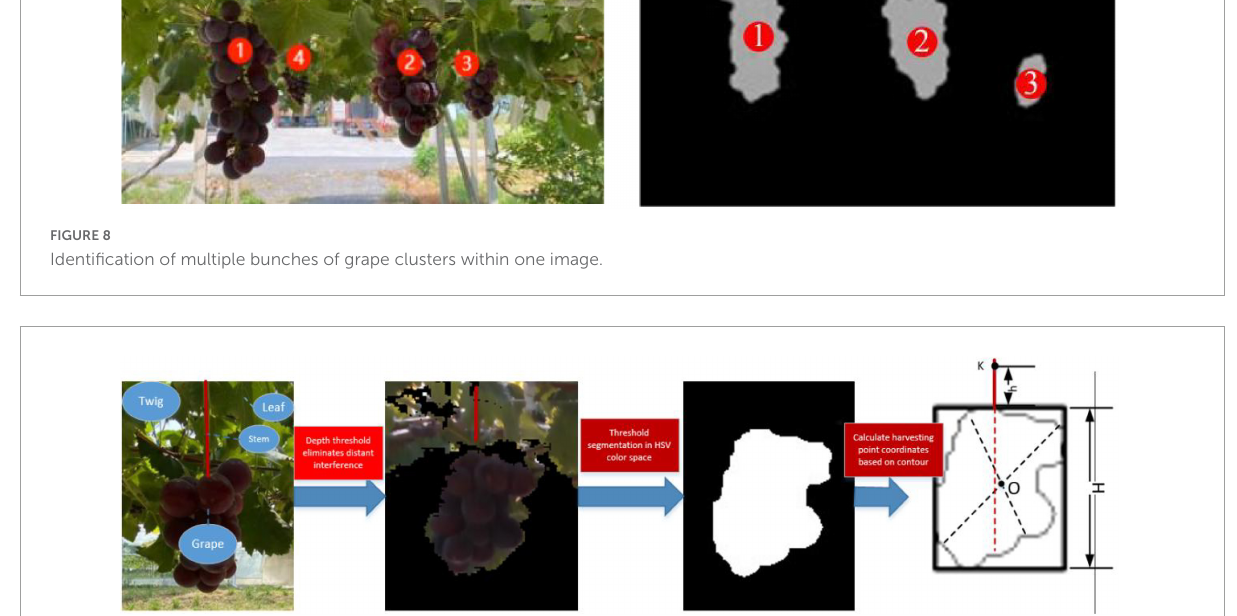
FIGURE9 Calculation of the stem-cutting